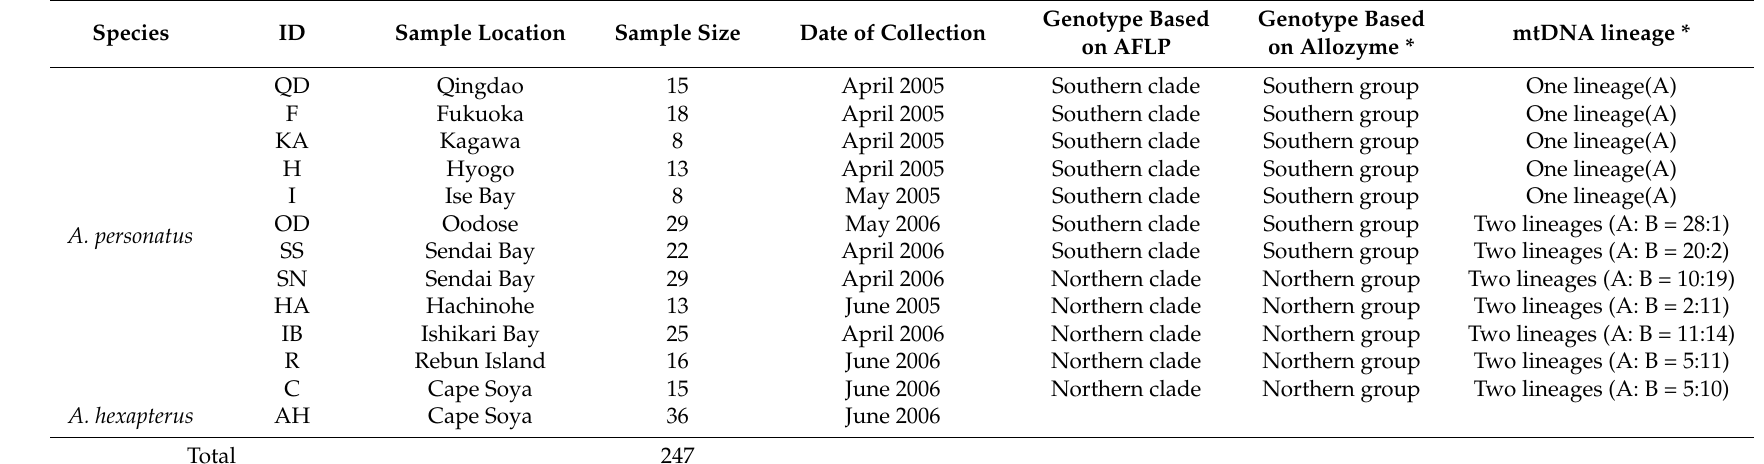
Table 1. Sampling information, number of genotypes based on Amplified fragment length polymorphism (AFLP) and allozyme analyses, and types of mtDNA